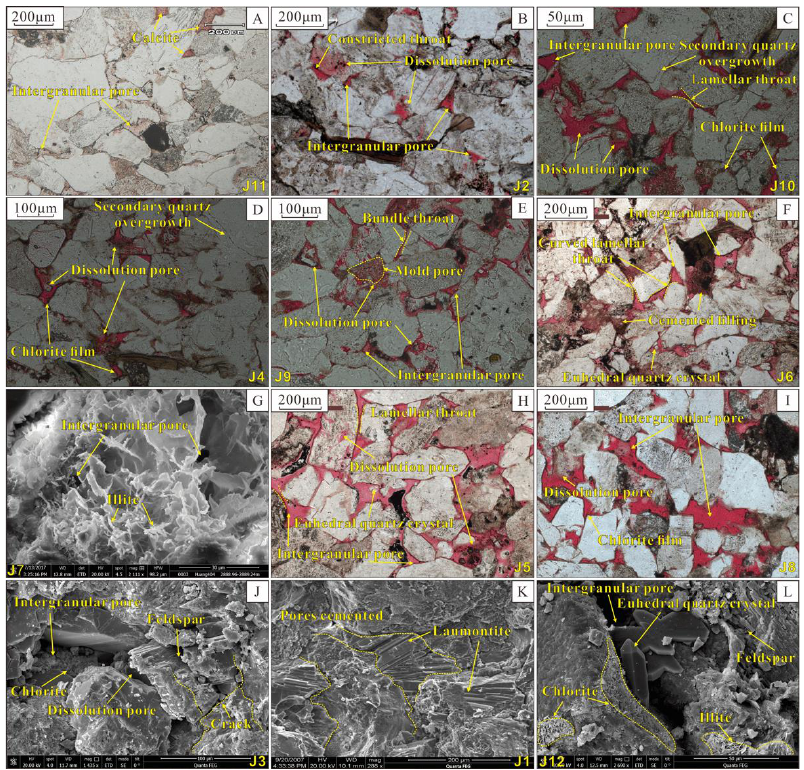
Figure 5. Microscopic characteristics of the pore-throat structure. Figures ( A – L ) represent 12 samples from J1 to J12 respectively. Table 2. The CTS results of the 12 typical samples.